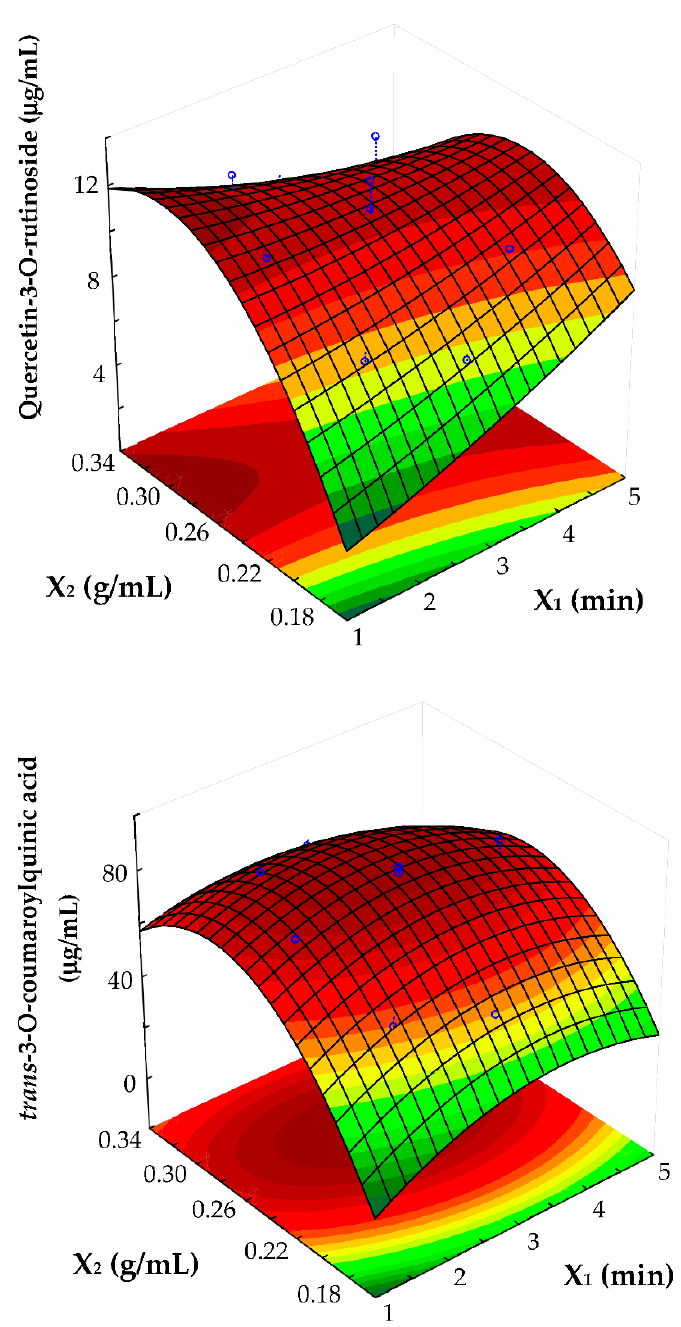
Figure 3. Response surface plots showing the effects of extraction time (X 1 ) vs. solid-solvent ratio (X 2 ) on polyphenols recovery from cherries pulp by UAE. Blue points retrace the CCD features.